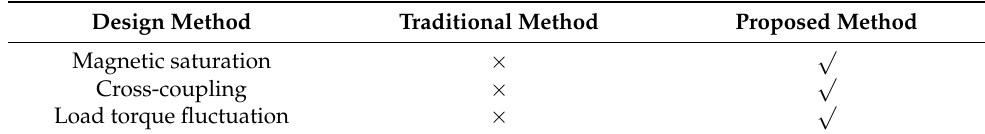
Table 1. The difference between proposal and traditions.